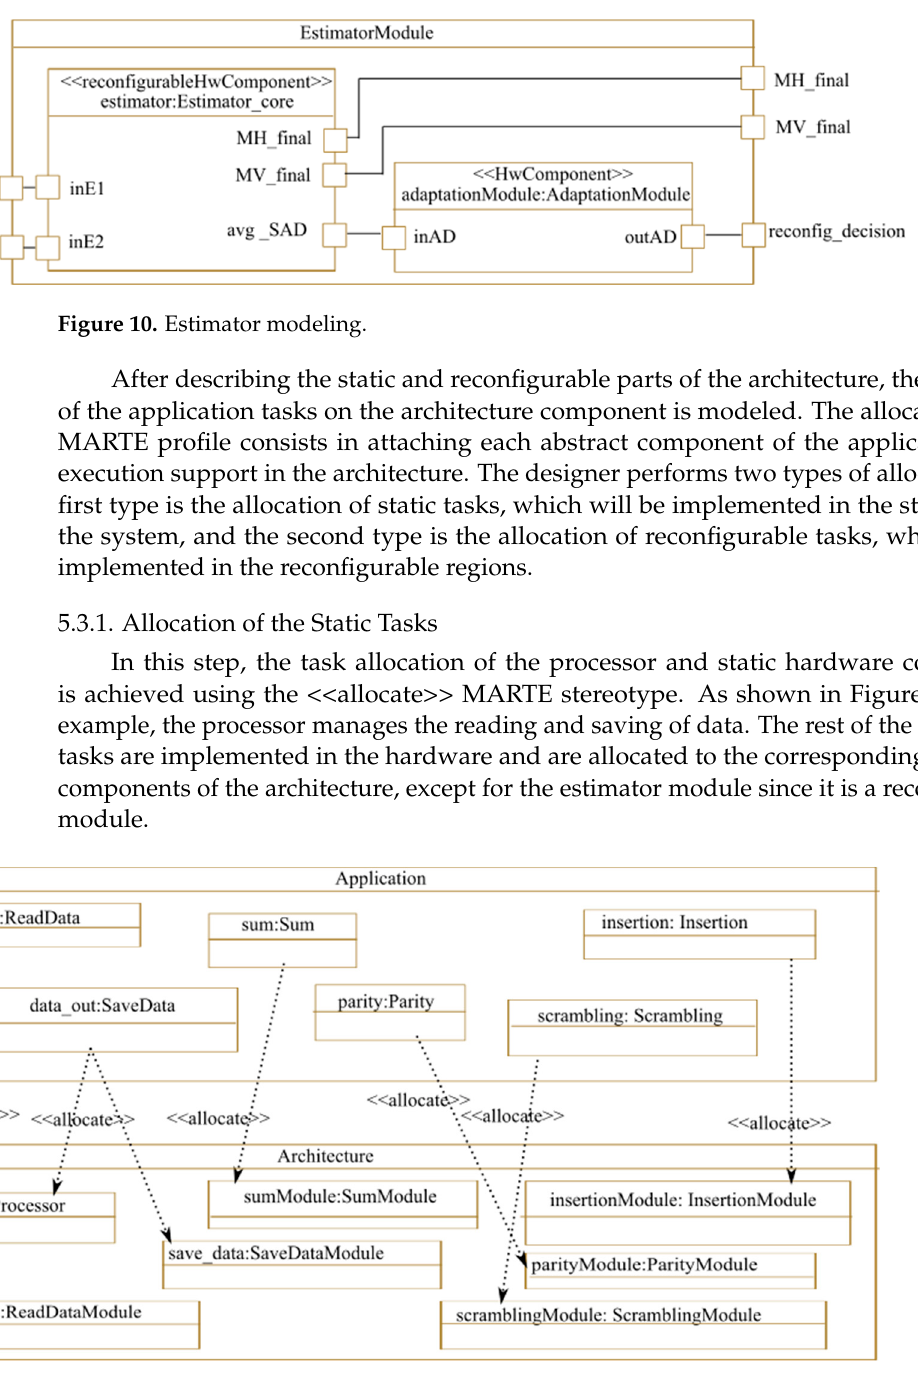
Figure 9. Architecture modeling.